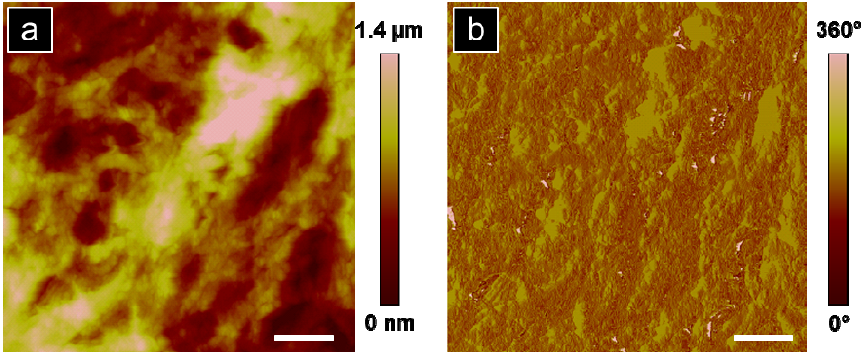
Figure 3. Representative AFM analysis of the dorsal striatum (30 × 30 µm) from a rat treated with G4 biotinylated PAMAM dendrimers: ( a ) topographic and ( b ) phase images. Scale bar equal 5 µm.